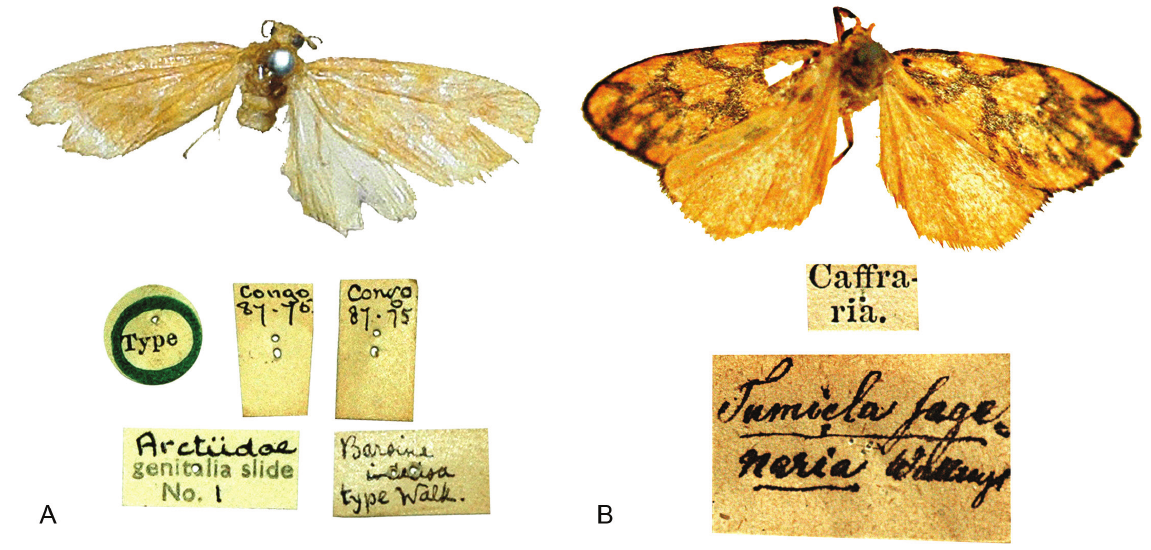
Fig. 2. — A . Afrasura indecisa , holotype ♂, Congo, in BMNH. — B . Tumicla sagenaria , holotype ♂, South Africa, in